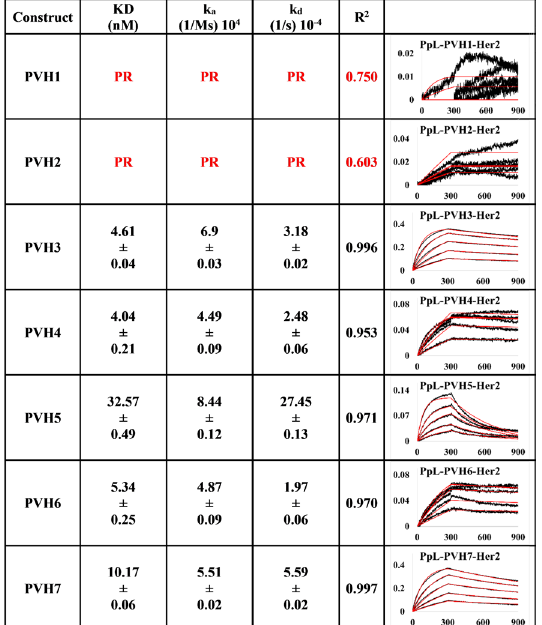
Figure 2. BLI measurement of trastuzumab IgM variants (HVH1-7) interacting with FcµR bound to AHC biosensor. KD, k R 2 , and fitting curves are shown according to the 1:1 model. PR indicates poor responses where the measurements have a poor R 2 value are shown in red. The x-axis and y-axis of the graph represent time (s) and response (nM), respectively. All values are rounded off to 2 decimal places. Triplicate experiments were performed, and standard errors were reported BIL measurements of pertuzumab and trastuzumab IgM variants to Her2